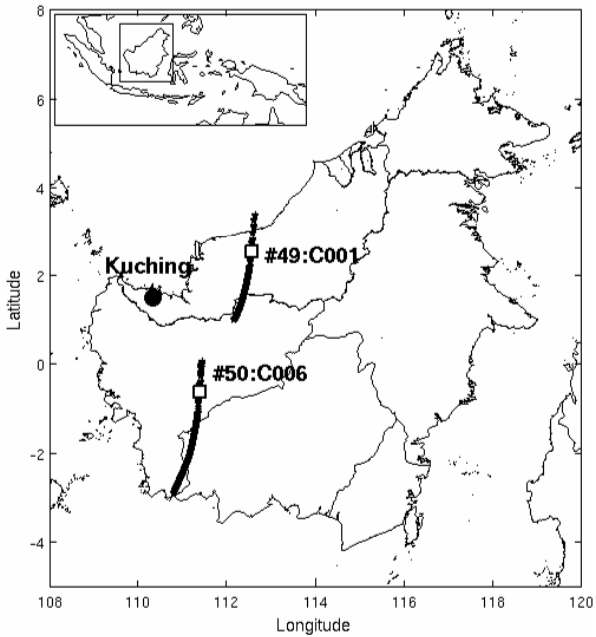
Fig. 2. Locations of tangent points for two COSMIC GPS RO events (#49: C001 and #50: C006) on 25 November 2006 near the radiosonde station at Kuching, Malaysia (solid circle). For both GPS RO events the tangent point moved from south to north. The south-end point and the square symbol correspond to 40km and about 4 km altitude, respectively.